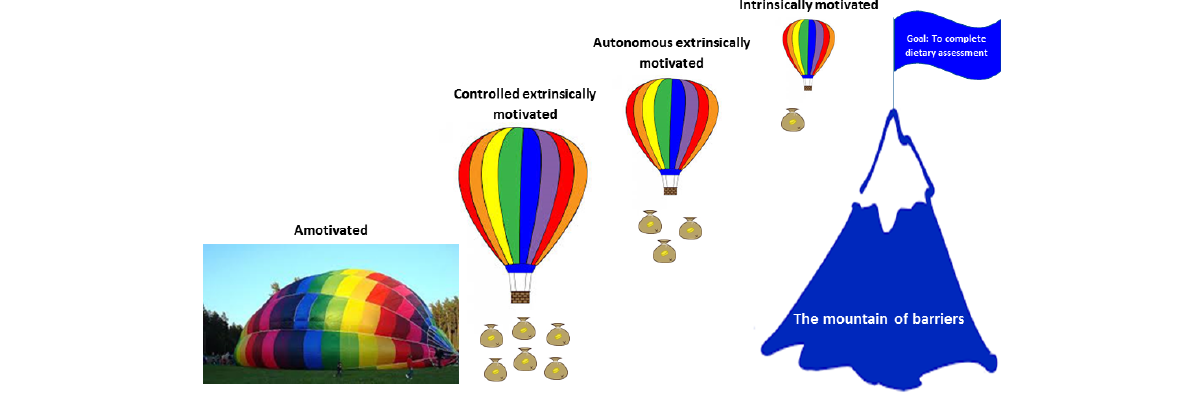
Figure 2. Illustration of adolescents' experiences of using a mobile phone dietary assessment app. To reach the goal of a complete dietary registration at the top of the mountain, participants must overcome several perceived barriers. Depending on their motivational type, subjects are in a smaller or larger balloon, and therefore need less or more facilitators (sandbags to let go of) to make it